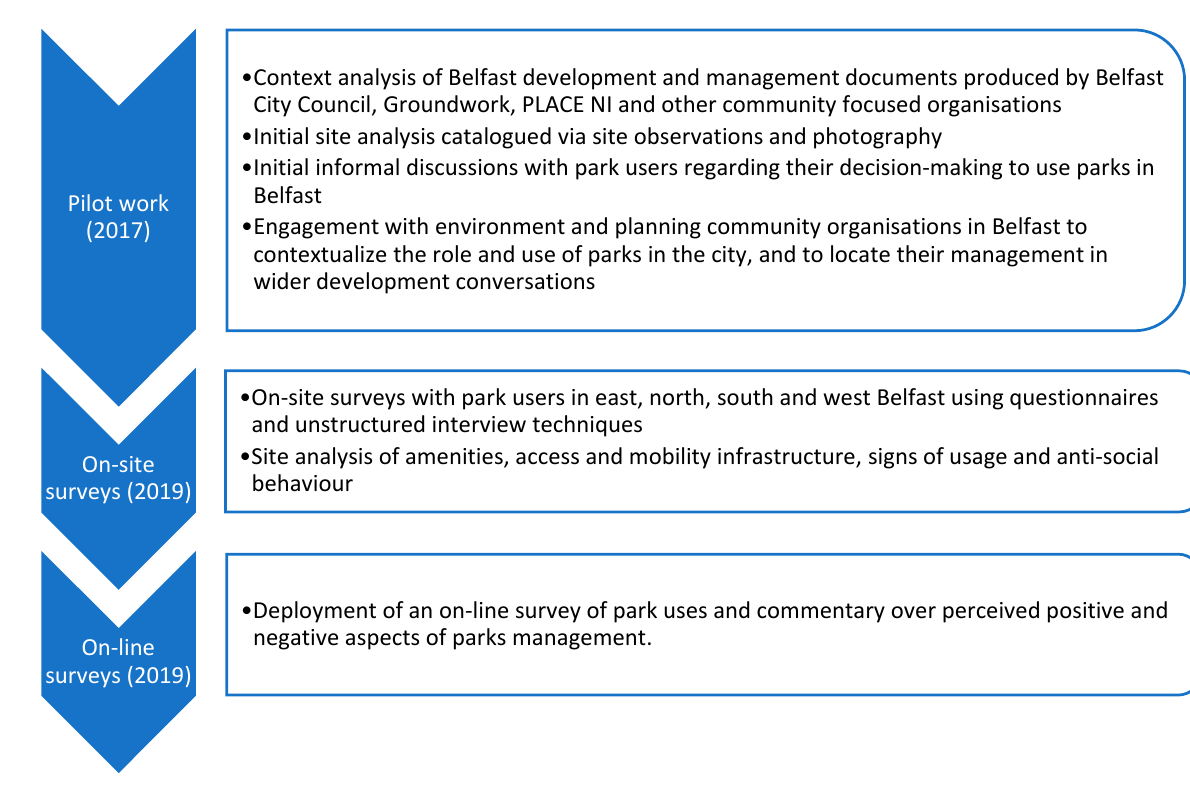
Figure 2. Methodological framework.